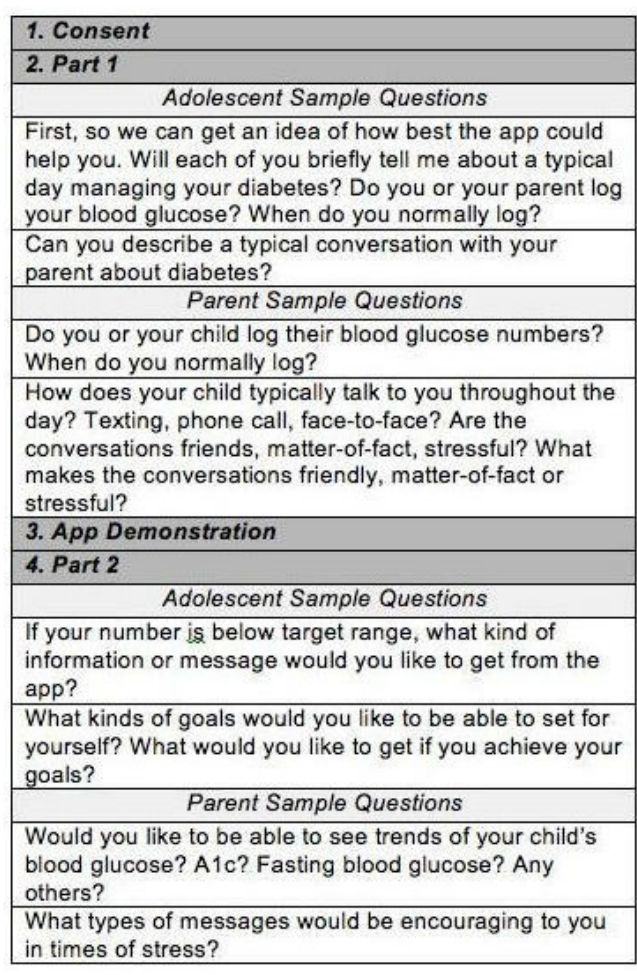
Figure 2. Focus group protocol